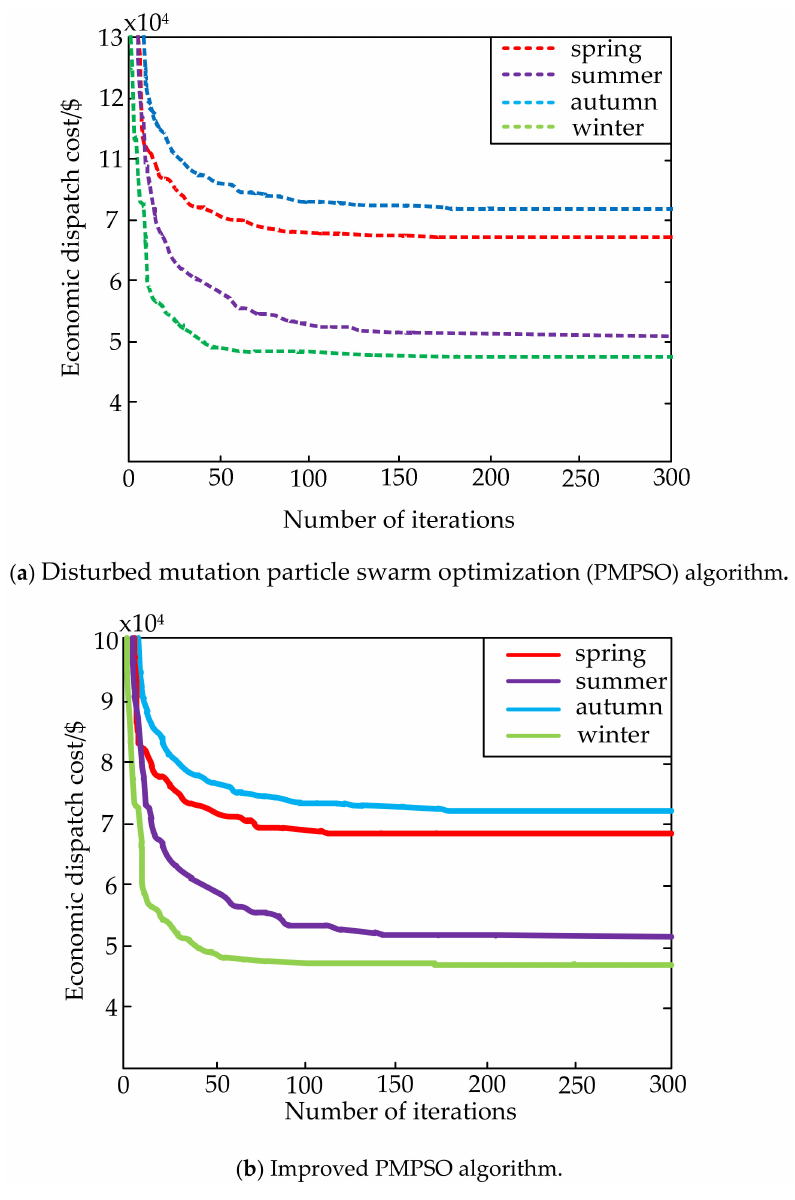
Figure 5. Comprehensive operating cost curve.